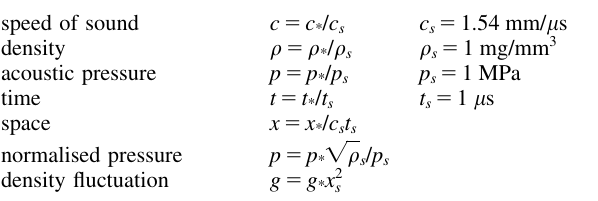
Table 2. Scales relating dimensional variables to dimensionless